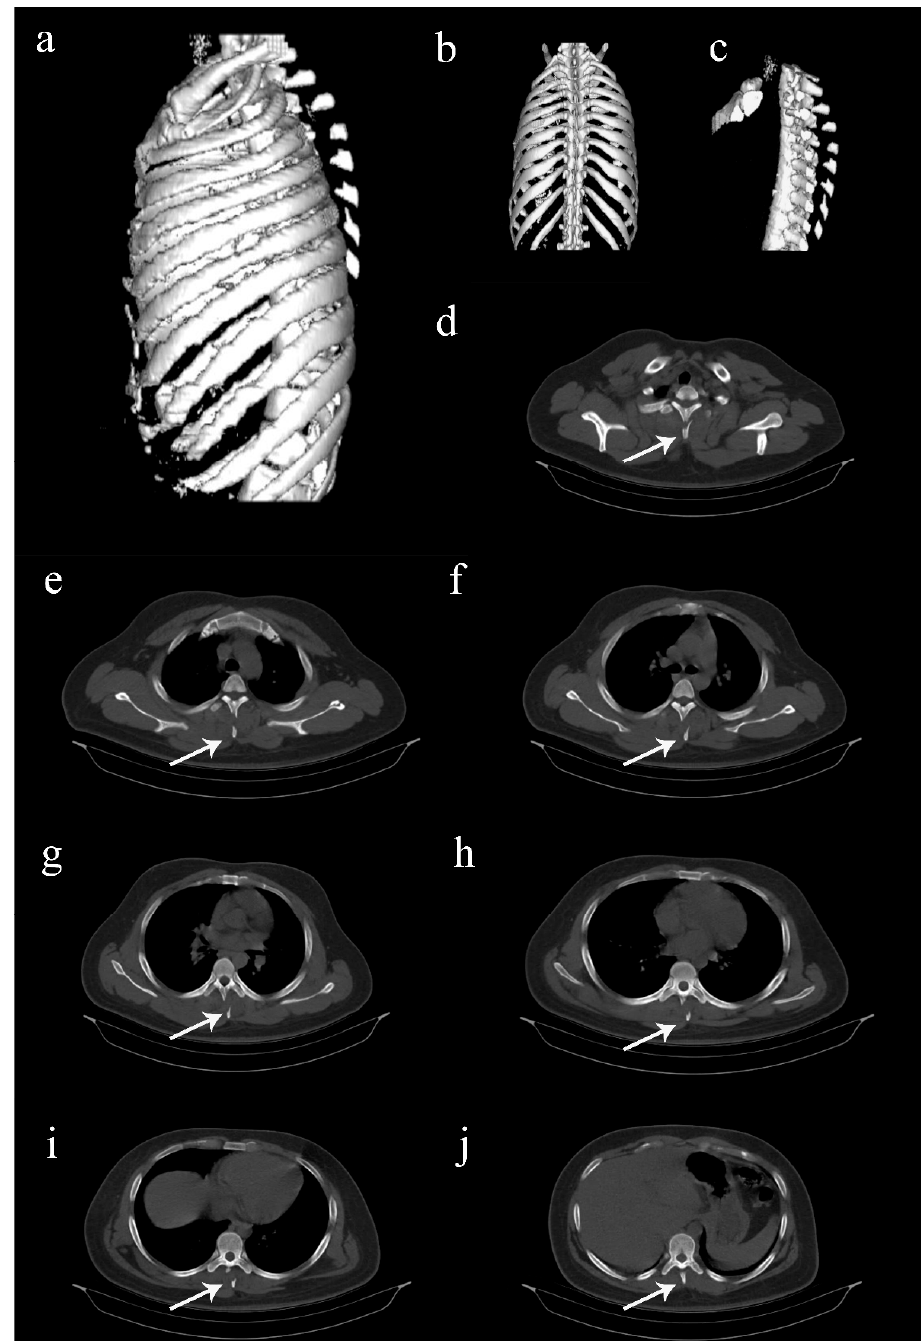
Figure 2. Computed tomography (CT) images of the thoracolumbar spine. ( a – c ) Three-dimentional reconstructed CT images showing multiple spinous process fractures extending from T2 to T8 levels, resembling clay shoveler’s fractures [1–5]. ( d – j ) Axial view CT images extending from T2 to T8 levels, showing the fractured spinous processes (arrows). Such involvement of multiple spinous processes in the thoracic spine is rare, and hence, sparsely reported [1–3]. Considering the stability of these fractures, it was decided to treat the patient conservatively. He was put on a thoracolumbar corset and was advised adequate bed rest for two weeks. Analgesics were provided, and self-care for the abrasions was taught. Protected weight bearing and mobilization exercises were started on the second week while on thoracolumbar corset support. The recovery was quick, and the patient was back to his full functional status by 6 weeks. Further follow-up was